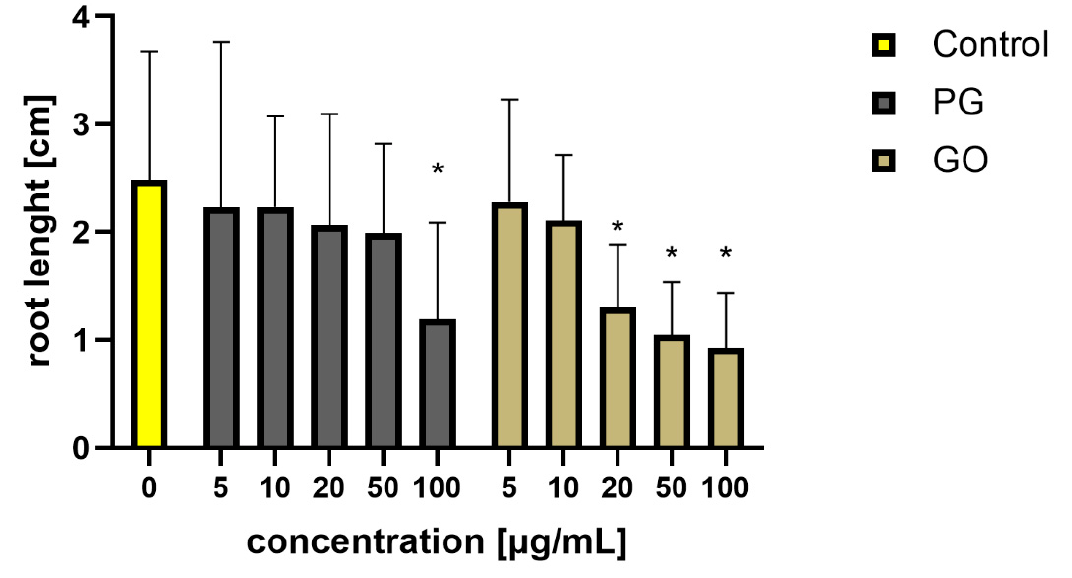
Figure 6. An average root length of Lemna minor treated with PG and GO. Values in the rows marked with an asterisk show statistically significant differences ( p < 0.05) as compared to the control assay. Abbreviations: C—control group (untreated cells); PG—pristine graphene; GO—graphene oxide.